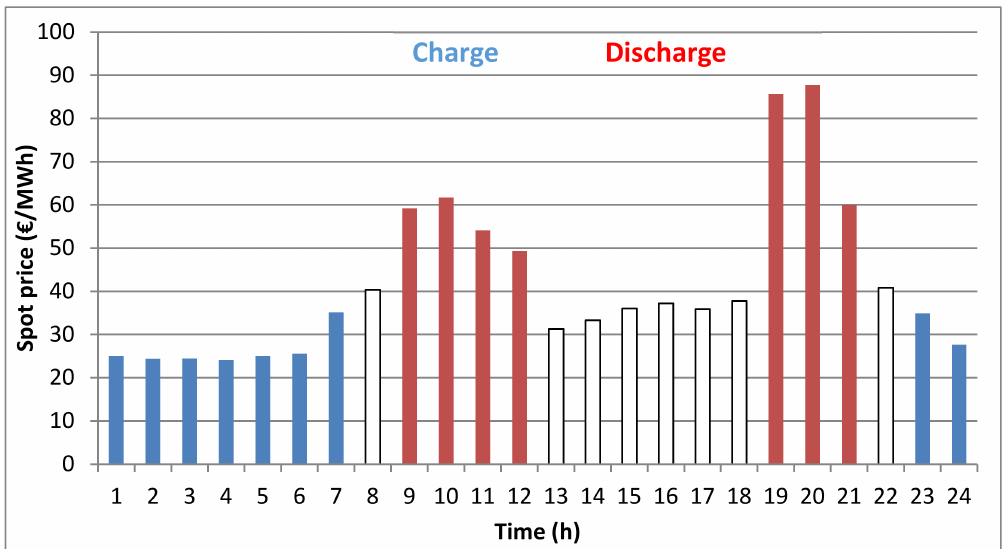
Figure 8. Operation strategy of a PHS power plant for given spot prices on a daily basis. Notes: white bars denote inactivity (neither discharging nor charging the upper reservoir); price variation derived (downscaled) from the Phelix future prices shown in Figure 7.